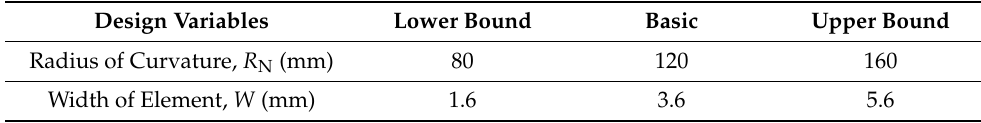
Table 3. Variation range of design variables for the N-subarray part.